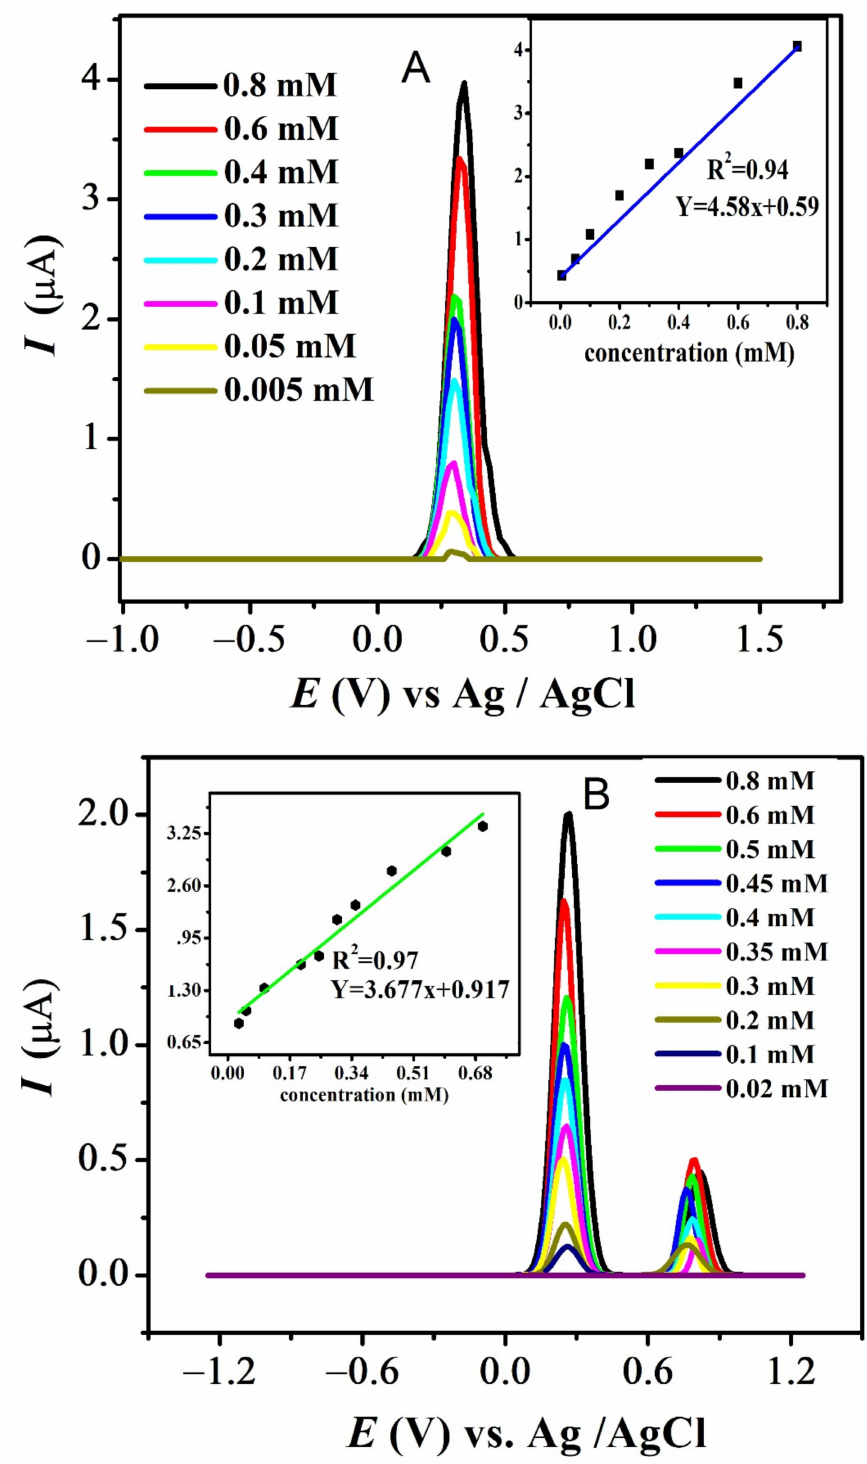
Figure 9. Concentration effect recorded in pH-7 at scan rate 0.1 V/s and inset plot of concentration (mM) vs. peak current ( µ A) for ( A ) FBA and ( B )